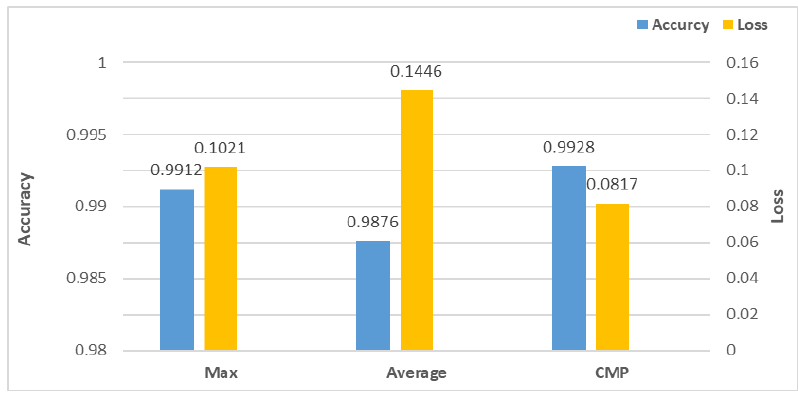
Figure 8. Pooling performance result using Caltech 101 data.